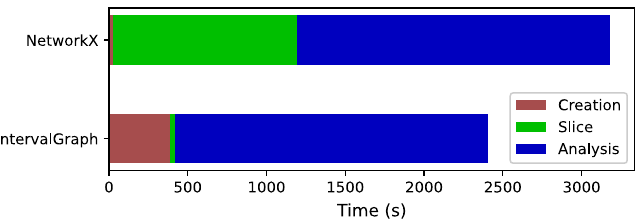
Fig. 4 Computation time per stage on the London Bikeshare data set. The cost of the increased creation time for IntervalGraph rapidly disappears when performing many time-based slices, which are much faster than